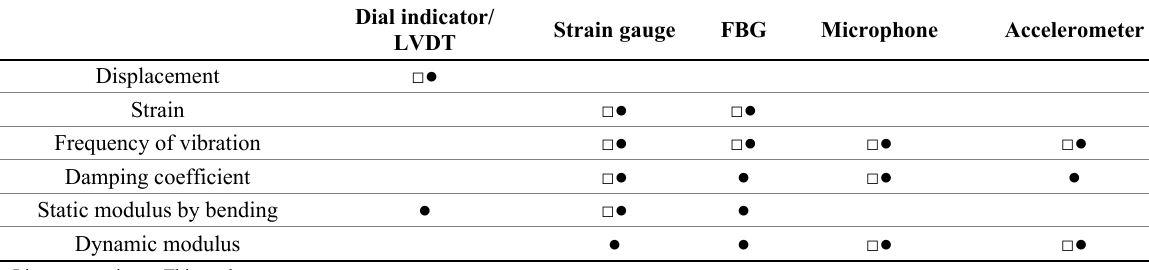
Table 1. Sensors applied to mortar and concrete monitoring.